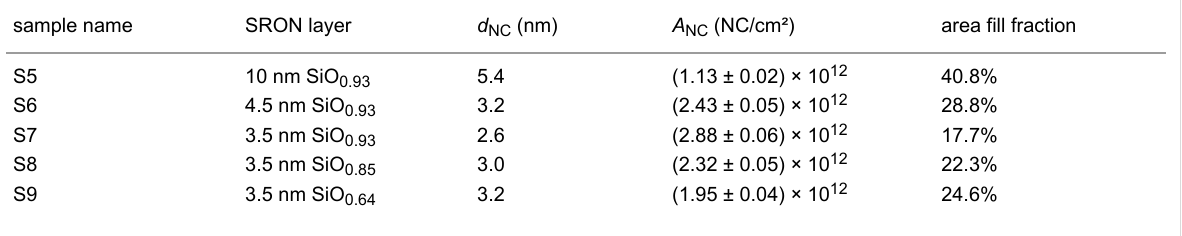
Table 2: Extracted parameters from the EFTEM analysis, d NC indicates the maximum of the log-normal distribution fit, whereas A NC is the Si NC areal